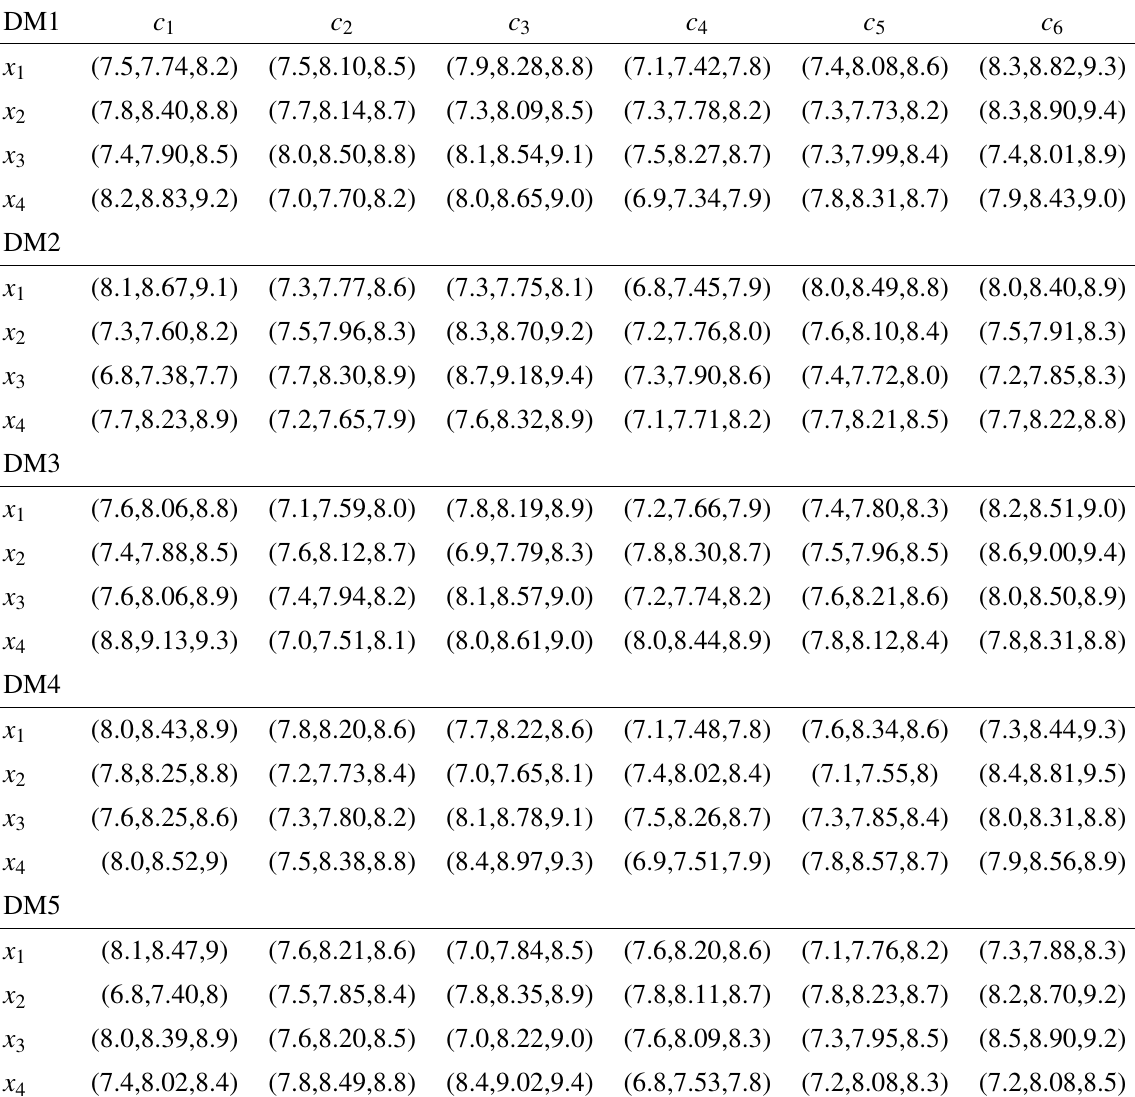
Table 5: The transformed individual decision matrix of DM1-DM5 in the final decision solution